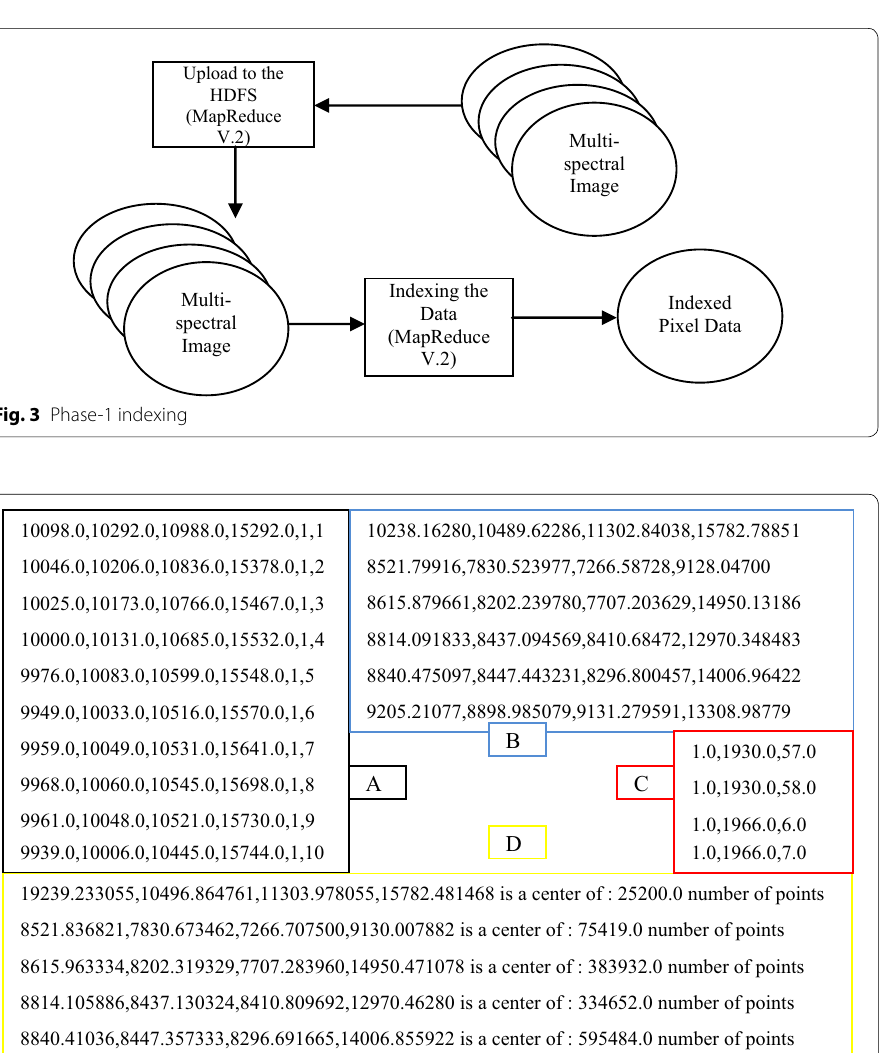
Figure 4 represents the total workflow which is divided into three main stages. In